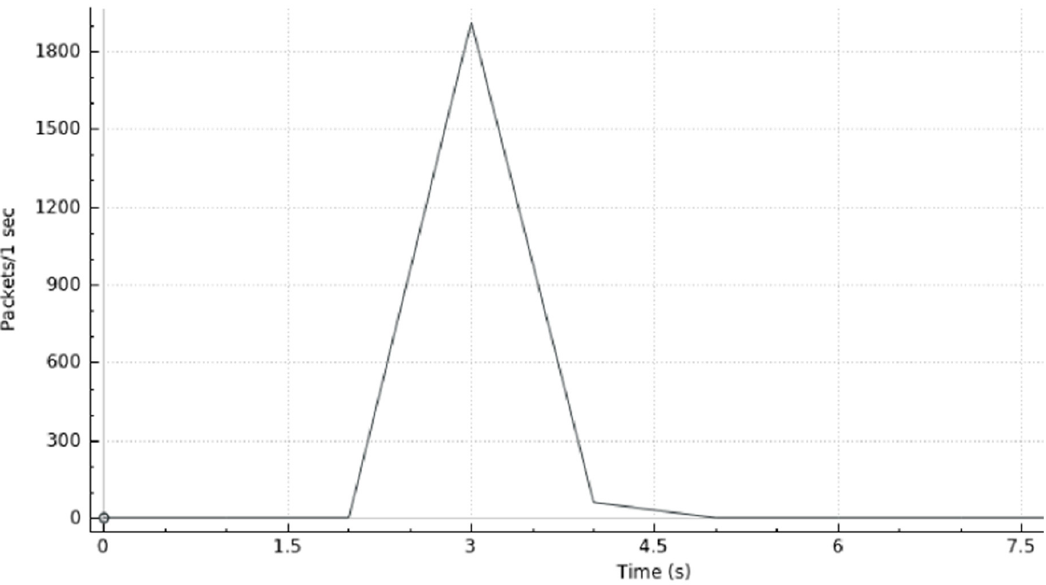
Figure 15. Scenario II—DDoS Detection and Mitigation. Table 5. Scenario II—Performance Results.